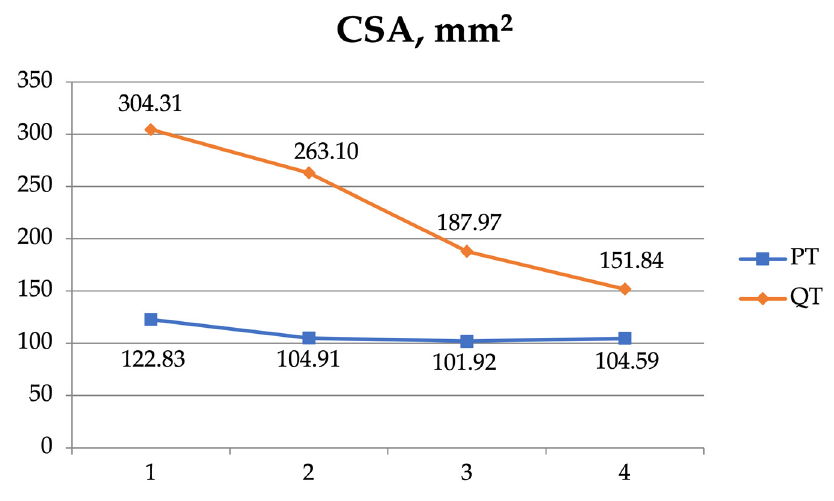
Figure 4. The perimeter of the patellar tendon (PT) and the quadriceps tendon (QT) at the 4 meas ‐ urement sites.